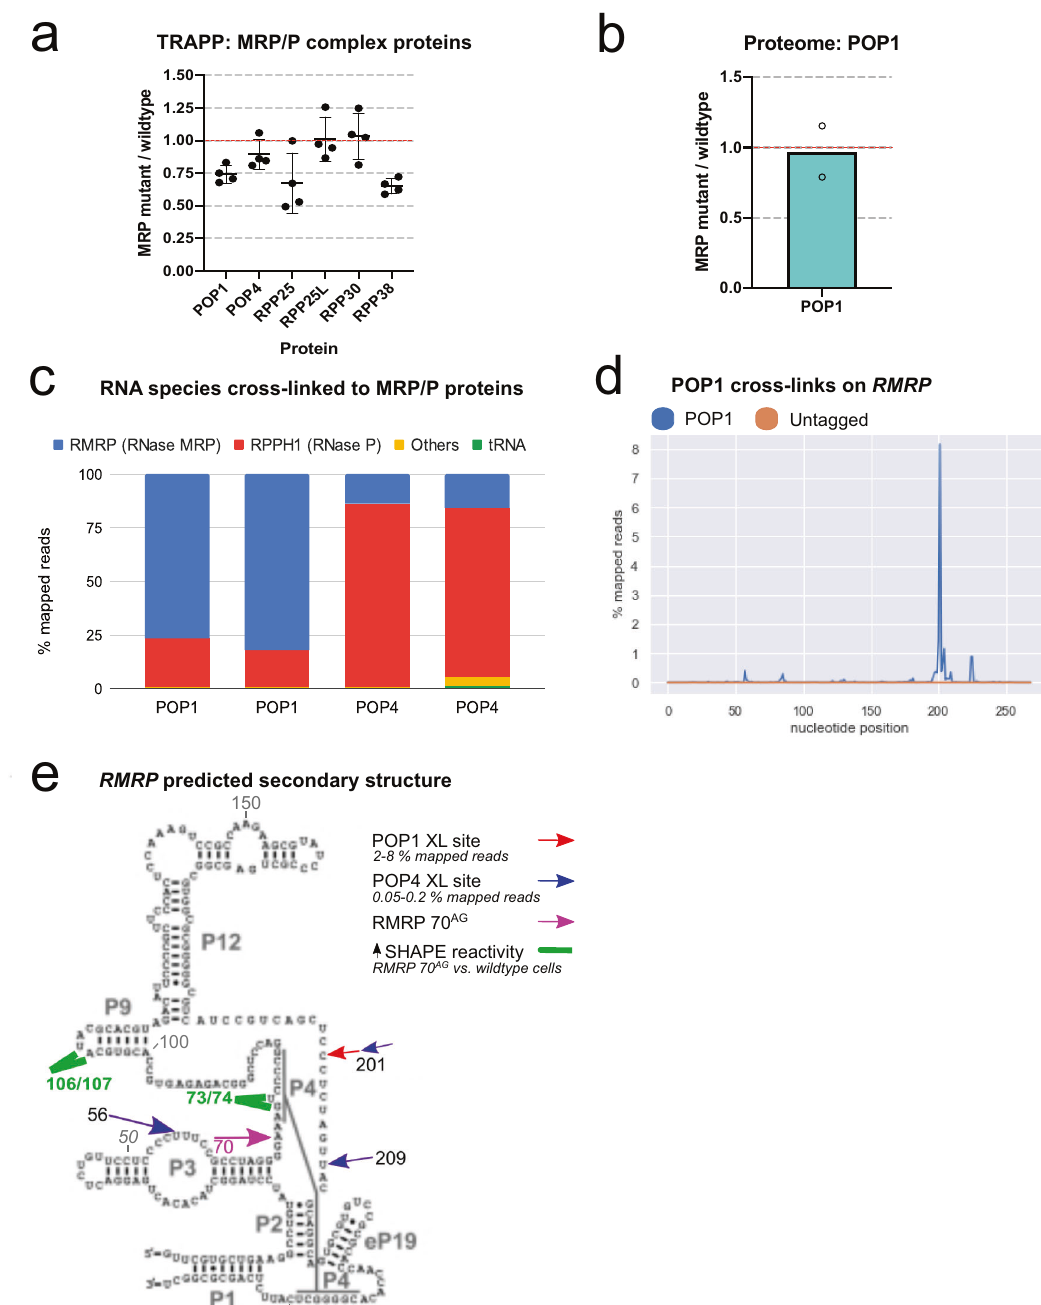
Fig. 5 70 AG mutation in RMRP reduces the abundance of intact RNase MRP complexes. a SILAC ratios (70 AG /wildtype cells) obtained for MRP/P complex proteins in TRAPP (mean and SD). Each dot represents data from an independent SILAC mix (total of 4 mixes, processed in 2 independent experiments). b SILAC ratios (70 AG /wildtype cells) obtained for POP1 protein in proteome. Includes data from two SILAC mixes, showing mean value. c RNA species recovered from MRP/P complex proteins in CRAC. Graphs shows relative proportion of mapped reads representing each indicated RNA or RNA biotype, in two independent experiments. d Pileup of reads containing single base deletions (indicating RNA:protein crosslink site) in RMRP ncRNA, in POP1 or negative control CRAC. Representative of results from two independent experiments. e Possible secondary structure of RMRP, indicating sites of crosslinking with two RNase MRP complex proteins (POP1 and POP4). Nucleotides with reproducibly increased SHAPE reactivity scores in RMRP 70 AG cells are indicated. The line designated P4 indicates a predicted interaction that generates a conserved pseudoknot structure. Source data are provided as a Source Data fi le (panels a , b and c ), and as processed data fi les (panel d